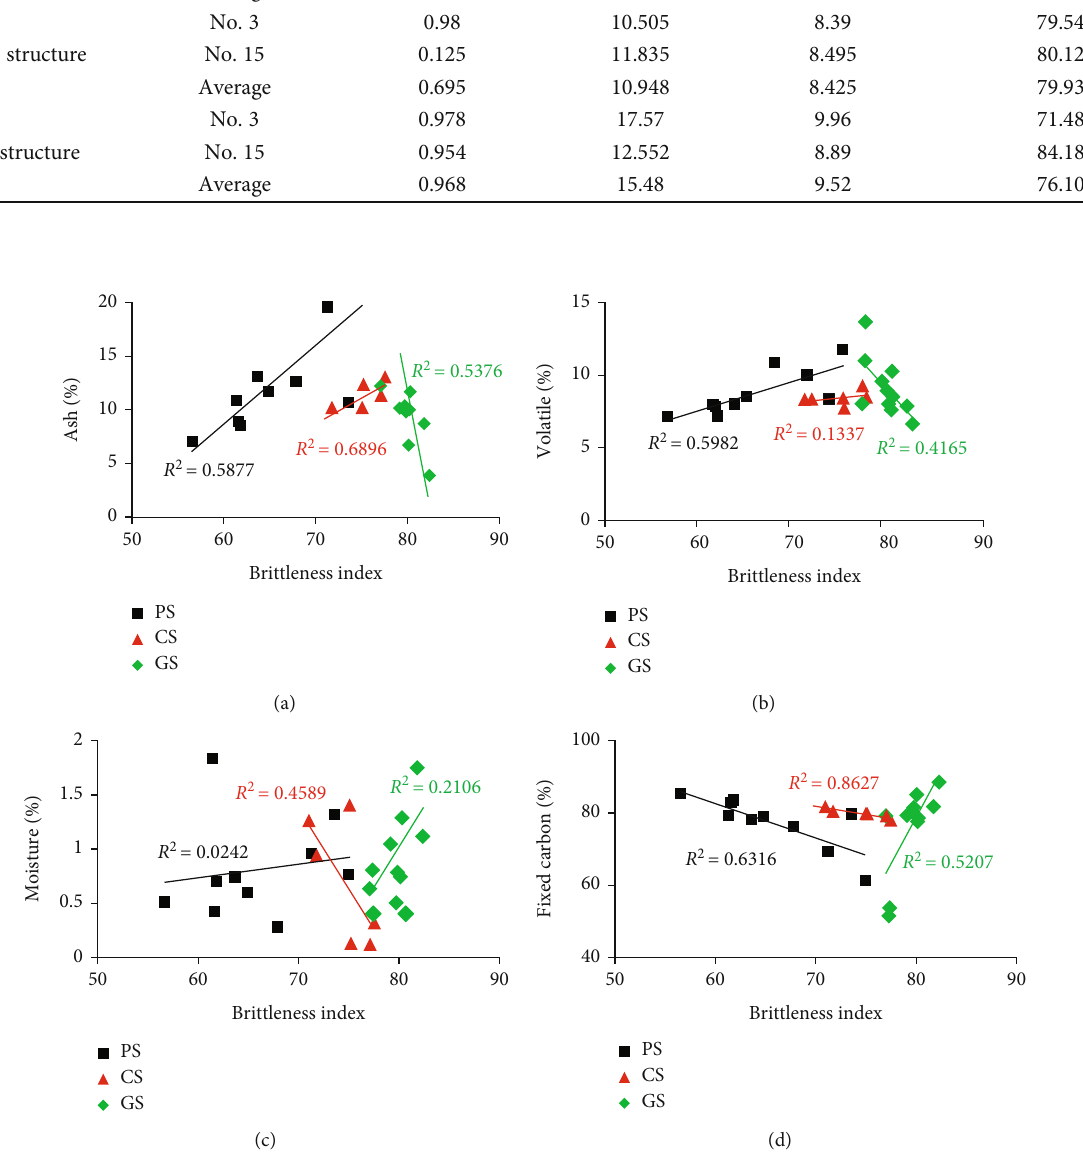
Figure 5: Relationship between the coal quality index and brittleness index. PS is primary structure, CS is cataclastic structure, and GS is granulate